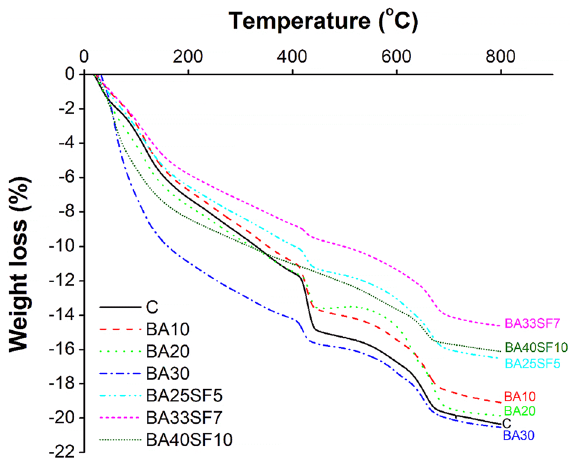
Figure 14. Comparison of thermogravimetric analysis of 91 days cured paste samples of control and other binary (OPC-BA) and ternary (OPC-BA-SF) concrete mixes.